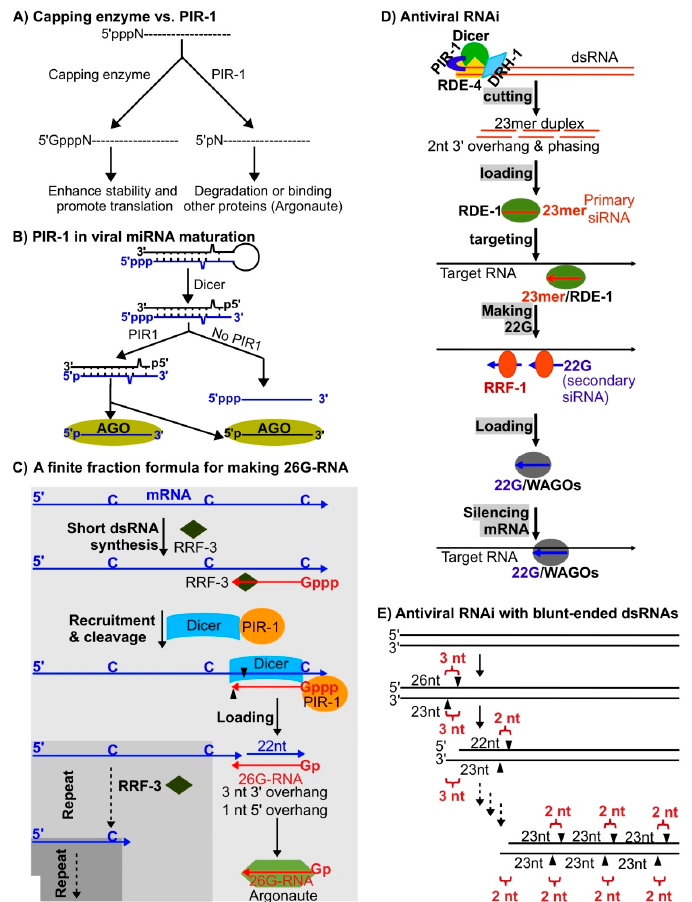
Figure 3. Antiviral RNAi mechanisms. ( A ) PIR-1 and capping enzyme mediated regulations of ppp-RNAs. ( B ) Mammallian PIR1 in viral miRNA maturation. Precursor viral miRNAs transcribed by RNA Pol III are cleaved by Dicer to generate duplex siRNAs, which are processed by PIR1 to convert the 5 ′ triphosphate (blue) to 5 ′ monophosphate and then loaded to Argonautes (AGO). Without PIR1, only the 3 ′ part siRNAs (black) are loaded to AGO. ( C ) 26G-RNA biogenesis: RRF-3 synthesizes short dsRNAs using C nts on template mRNAs, PIR-1 / Dicer is recruited to the triphosphorylated dsRNAs, Dicer utilizes a special mode to cleave dsRNAs to generate duplex siRNAs composed of 26G-RNAs and 22mer RNAs with a 3-nt 3 (cid:48) overhang, PIR-1 removes two phosphates from the triphosphate group on 26G-RNAs, 26G-RNAs are loaded to Argonautes, and the truncated template mRNAs are reused to generate more 26G-RNAs again and again using the same steps as above (the overall process is like a mathematical finite fraction formula). ( D ) Antiviral RNAi mechanism: the Dicer / DRH-1 / PIR-1 / RDE-1 complex cleaves dsRNAs to generate duplex 23mer primary siRNAs with a 2-nt 3 (cid:48) overhang, single stranded primary siRNAs are selectively loaded to Argonaute RDE-1 to form primary RNA-induced silencing complexes (RISC), these RISCs bind target RNAs, RdRP RRF-1 is recruited to generate secondary siRNAs (22G-RNAs), 22G-RNAs are loaded to worm-specific Argonautes (WAGO) to form secondary RISCs, and these RISCs silence target RNAs. ( E ) Processing of dsRNAs with blunt ends: the first cut by Dicer generates a duplex siRNA composed of one 26mer and one 23mer siRNAs with a 3-nt overhang, the second cut generates a duplex siRNA composed of one 23mer and one 22mer siRNAs with a 2-nt overhang, and the following processive cuts generate duplex siRNAs composed of two 23mer siRNAs with a 2-nt